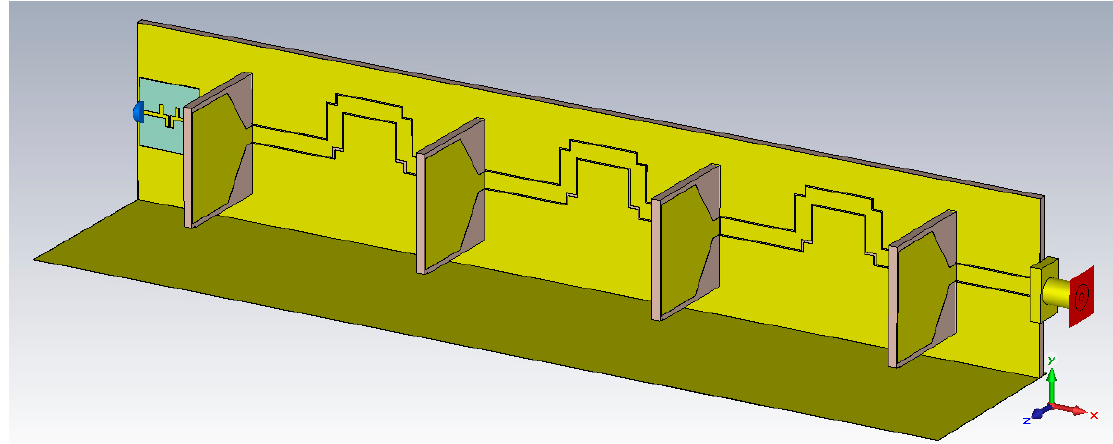
Figure 12. Perspective view of the Proposed Bandwidth-Enhanced Frequency Scanning Fan Beam Array Antenna with bandpass filter integrated into the feedline.